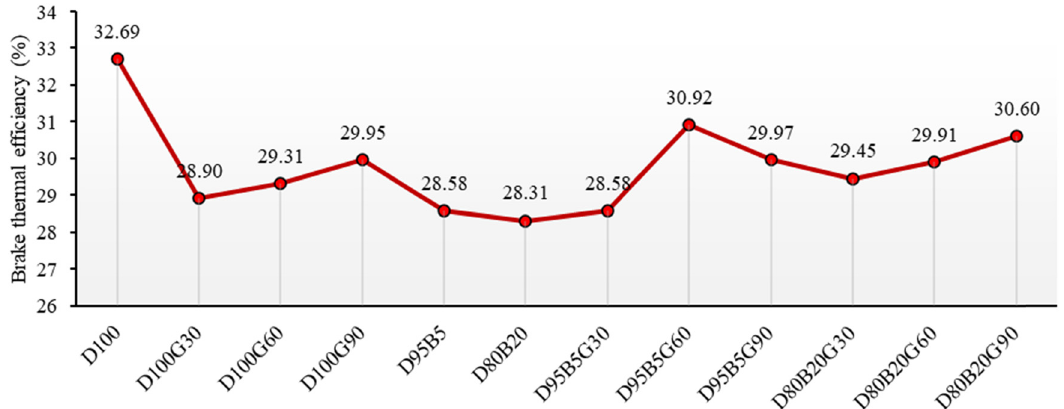
Figure 4: Variations in the BTE for di ff erent fuel